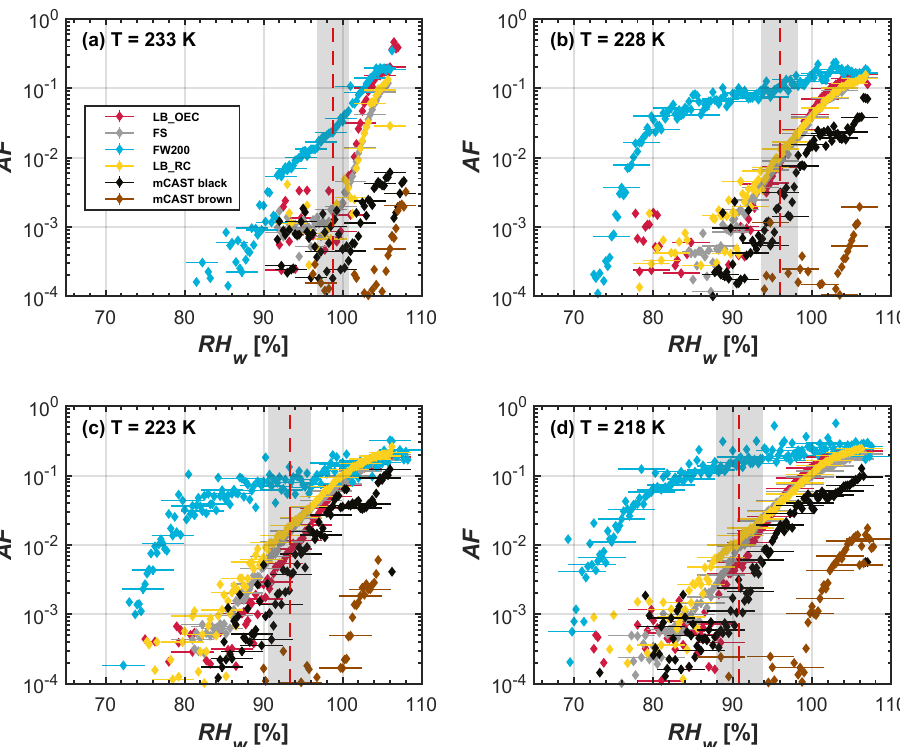
Figure 3. Mean RH scans of 400nm mobility diameter soot particles, showing AF as a function of RH w for different temperatures in the cirrus regime. Red, dashed lines represent expected homogeneous freezing conditions according to Koop et al. (2000), and the gray shaded regions indicate the calculated RH w variation across the aerosol lamina in HINC. Uncertainties, given for every fifth data point, are as in Fig.